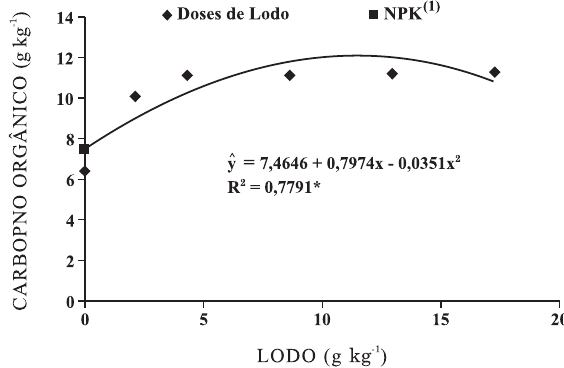
Figura 1. Variação dos teores de C orgânico total no solo em função da aplicação do lodo anaeróbio da estação de tratamento de efluentes de parboilização de arroz. * Significativo a 5 %. (1) Tratamento NPK incluído como referência fora da análise de